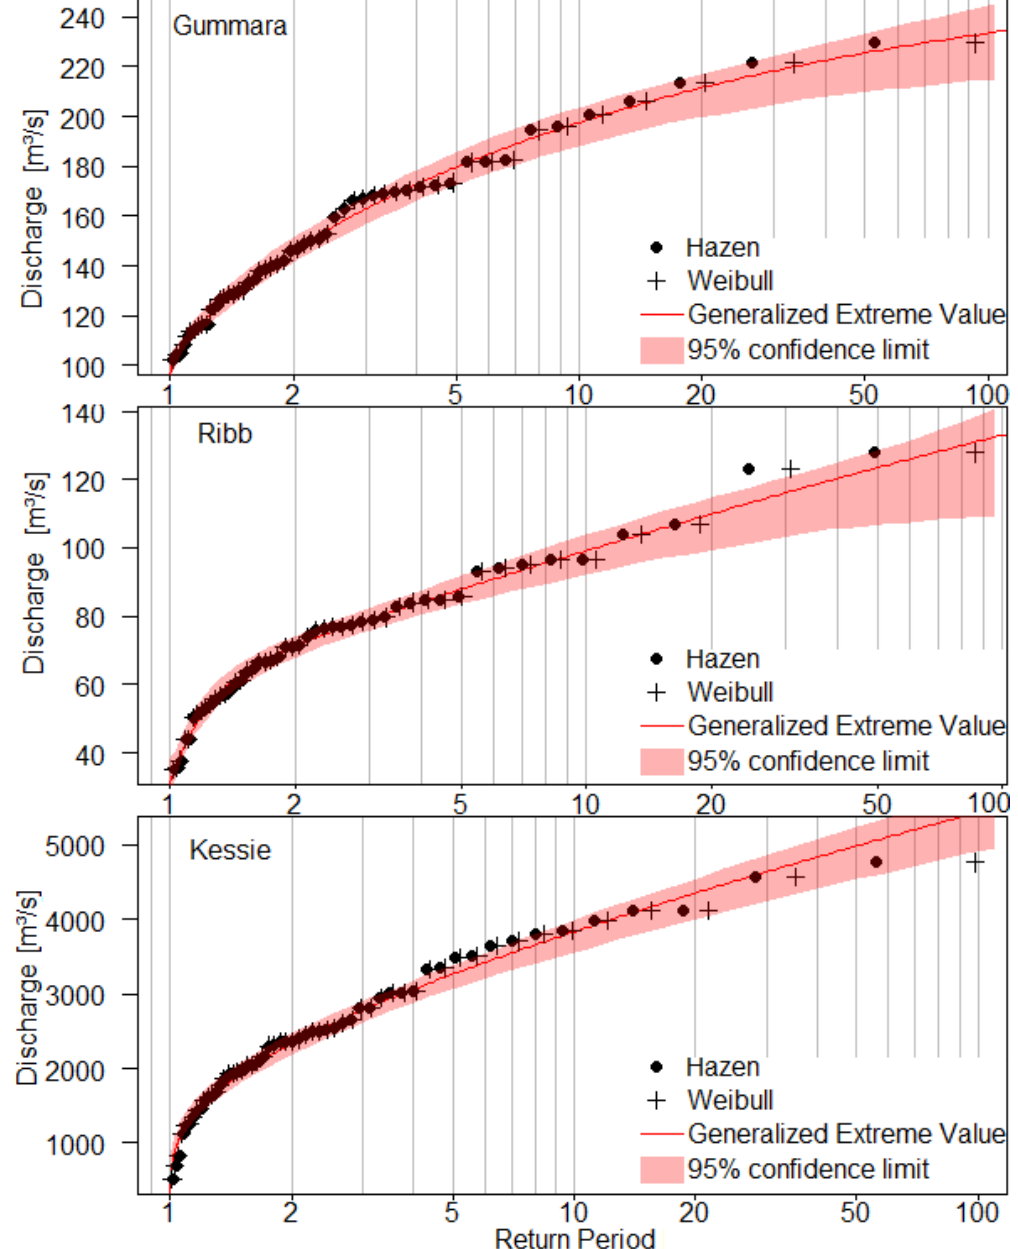
Figure 7. The flood frequency curves with 95% confidence limits for Gummara (top), Ribb (middle), and Kessie (bottom) gauging